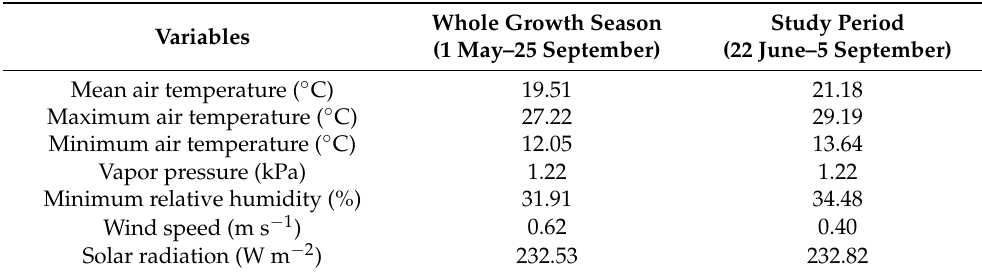
Table 1. Average daily meteorological variables for the whole growing season and the study period in 2020,